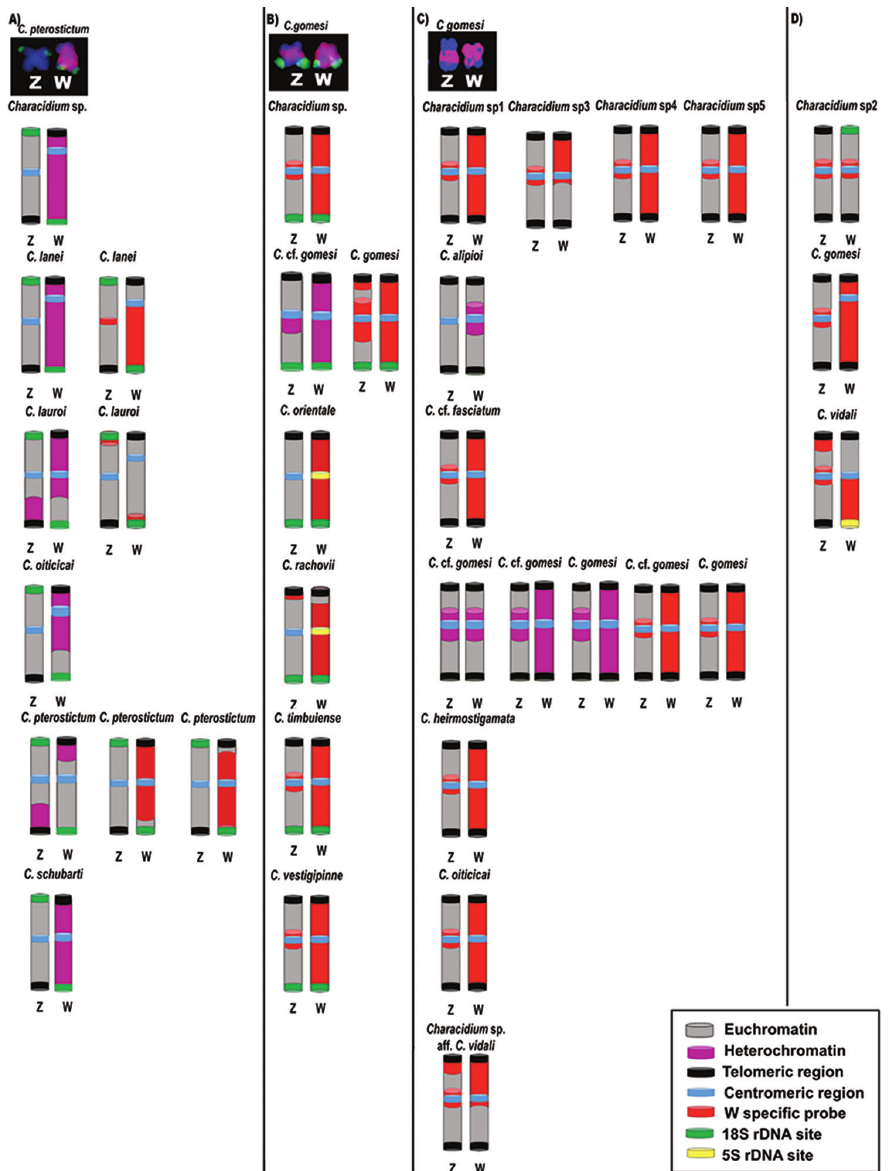
Figure 3. Idiograms showing main characteristics already identified for the ZZ/ZW sex chromosome system in Characidium species. It was highlighted the position of the centromere, distribution of euchro- matin and heterochromatin, W-specific probes, and rDNA sites. The a column detaches the species carry- ing 18S rDNA sites on the short and long arms of the Z and W chromosomes, respectively; the b column highlights the species bearing 18S rDNA sites on the long arms of both Z and W chromosomes; the c column shows the species that do not present 18S rDNA sequences on either Z or W chromosomes; the d column presents the species bearing Z and W chromosomes with unusual characteristics, including morphology, 18S and 5S rDNA sites, and W-specific probe